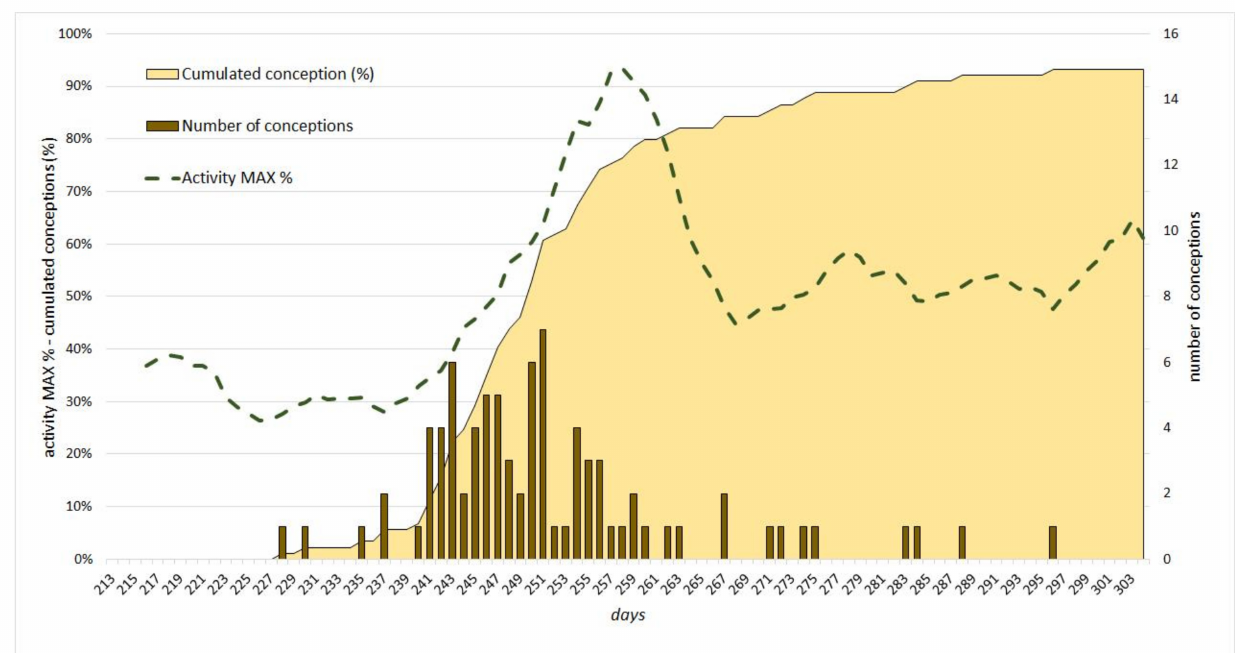
Figure 1. The number of conceptions of red deer hinds and activity trends of stags in the study period. The maximum activity saturation curve is smoothed by 7-day moving